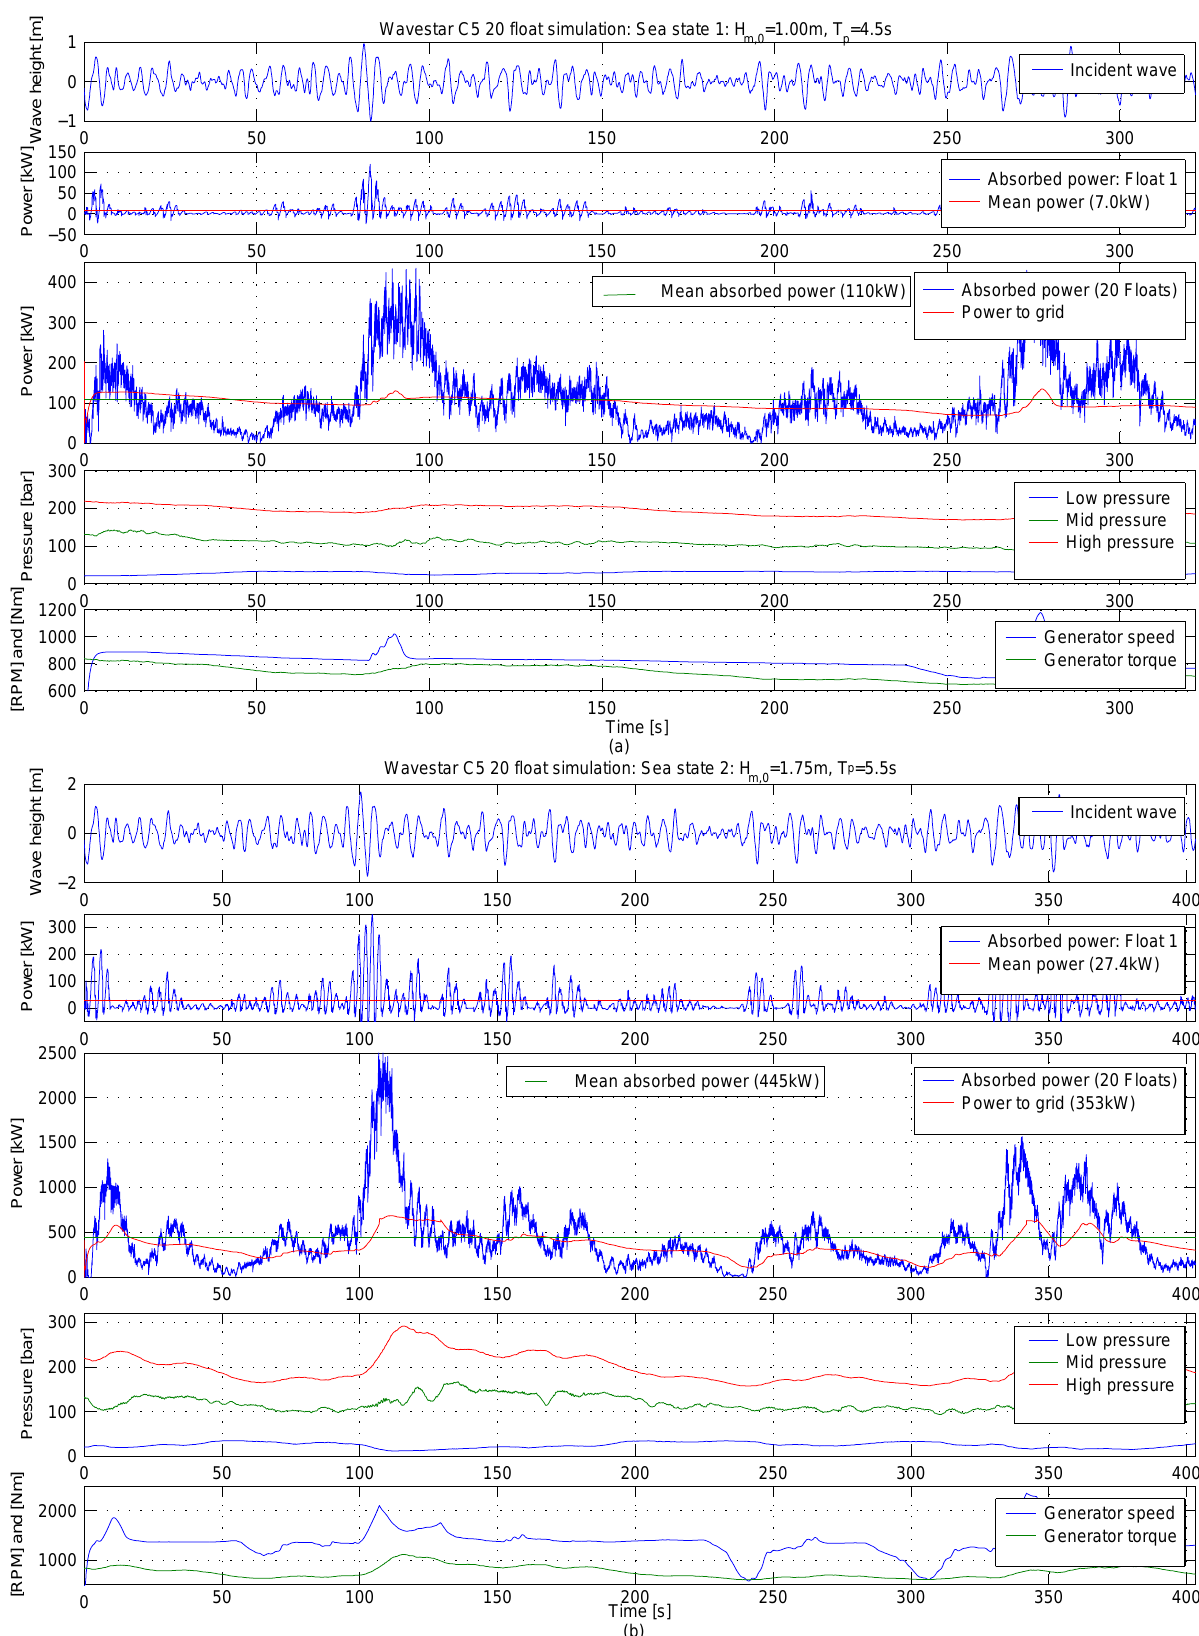
Figure 26. ( a ) PTO simulation results for Wavestar C5 for sea state 1, H = 4.5 s; and ( b ) PTO simulation results for Wavestar C5 for sea state 2, T p = 1.75 m, T = 5.5 H m,0 p